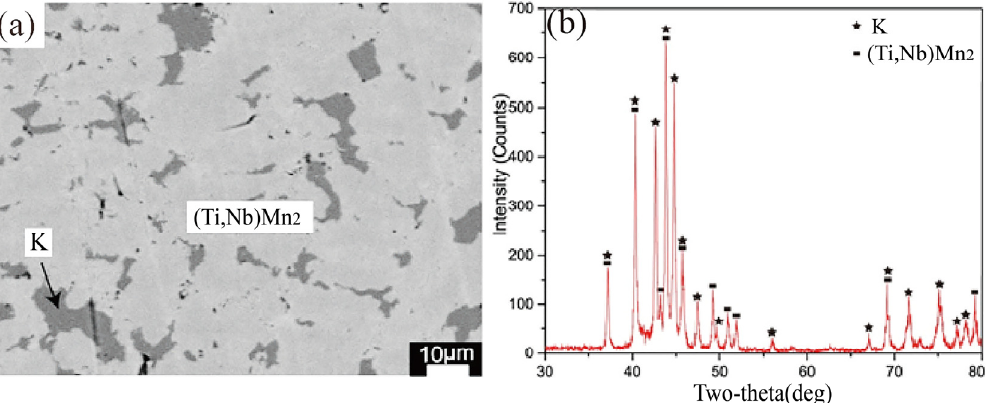
Figure 9. Alloy A10 annealed at1173K for 90 days: ( a ) back-scattered electron (BSE) images and ( b ) XRD patterns.